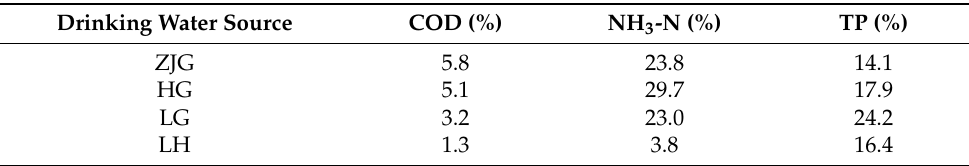
Table 3. The percentage bias (PBIAS) of the simulated water quality.